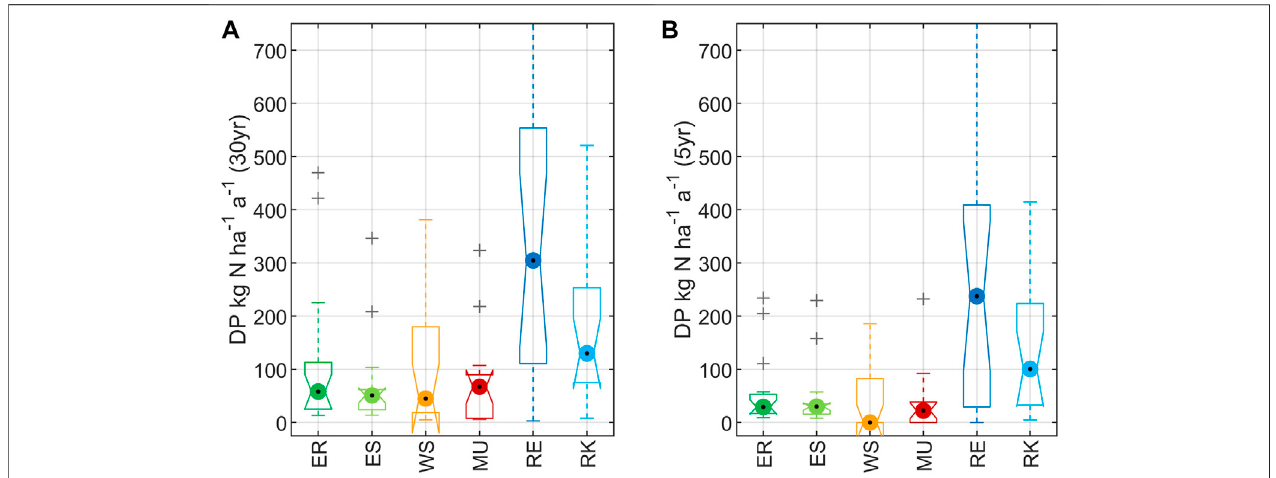
FIGURE5 | Comparison ofpotential fl oodplain denitri fi cation capacity between the study areas. Upscaling was derived using average inundation days per year for multiplication.Boxlines showupperand lowerquartiles. Whiskers extendtothe95thand fi fthpercentiles. (A) Databasis (cid:2) dailywaterlevels1988 – 2017.Upper whisker of RE extends to 1013.32 mg N ha − 1 a − 1 . (B) Data basis (cid:2) daily water levels 2013 – 2017. Upper whisker of RE extends to 898.32 mg N ha − 1 a − 1 .